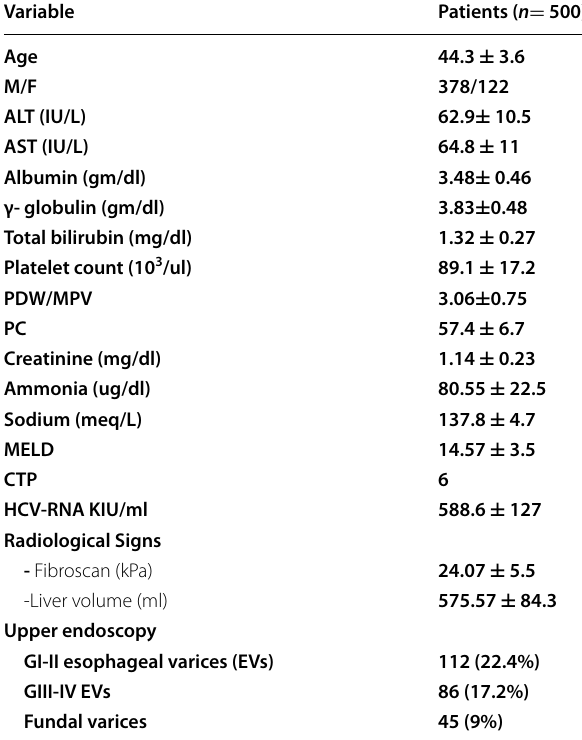
Table 1 Patients’ baseline laboratory, ultrasonographic,